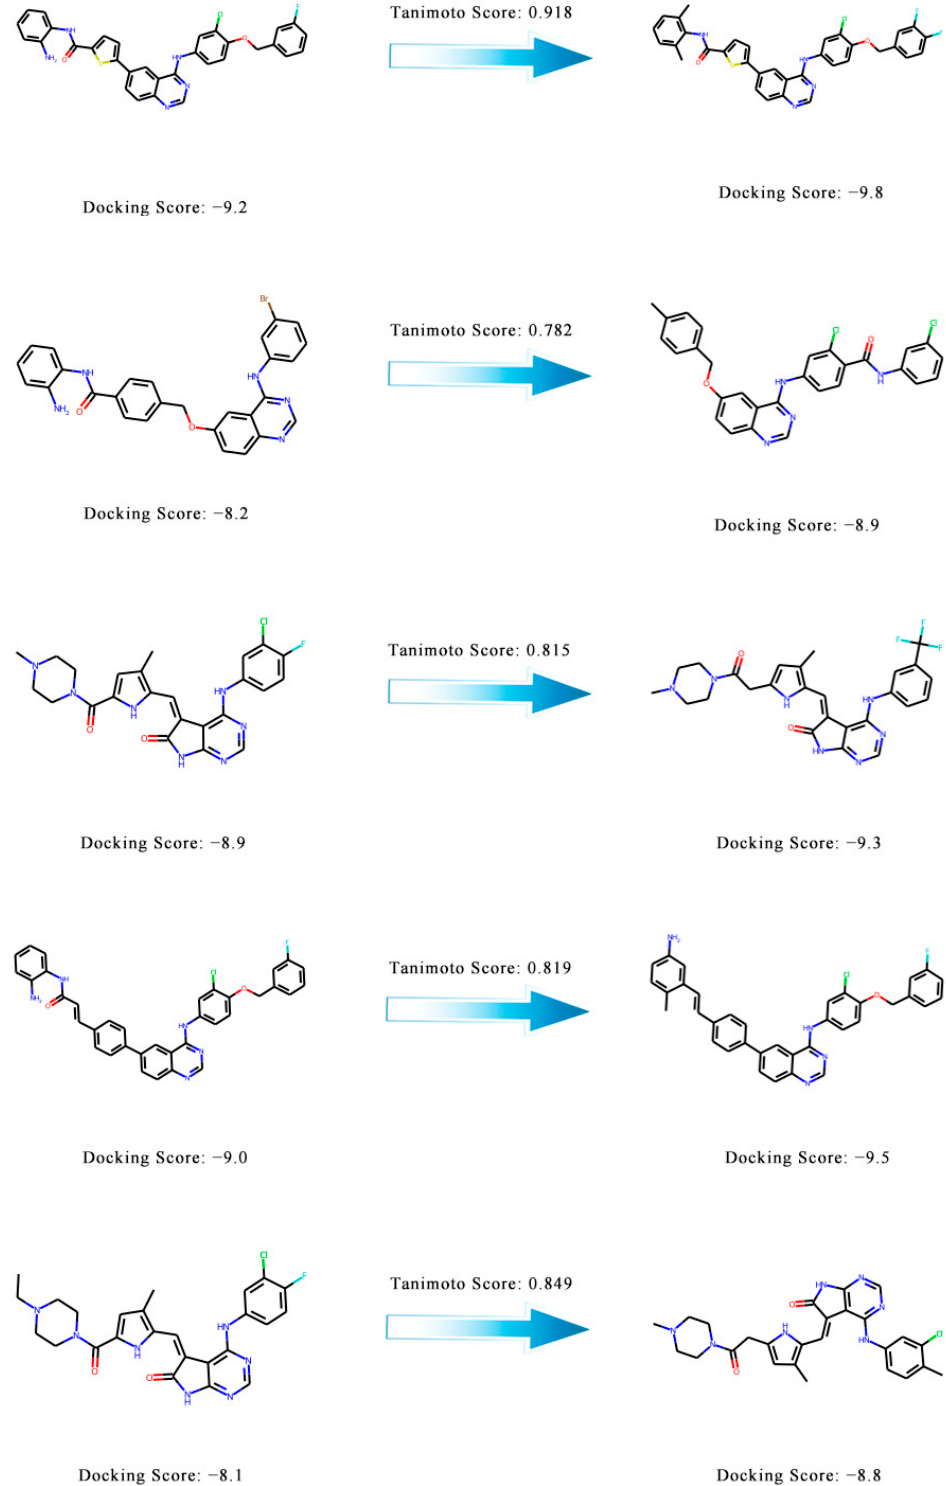
Figure 7. Five pairs of molecules with similarity scores and docking scores. The Tanimoto scores of the known active compounds (left) and the generated molecules (right) are shown above the arrows. The docking scores are shown below the molecular structure.